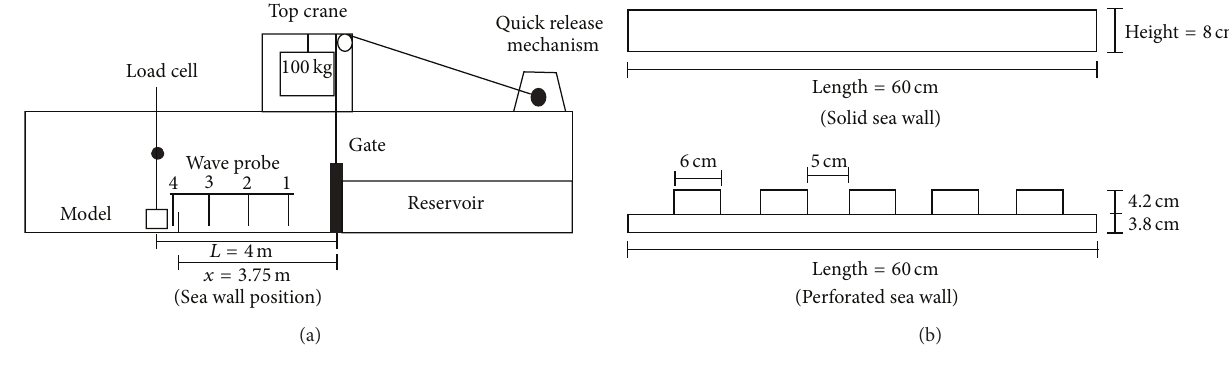
Figure 1: (a) Experimental setup. (b) Sea walls (solid and